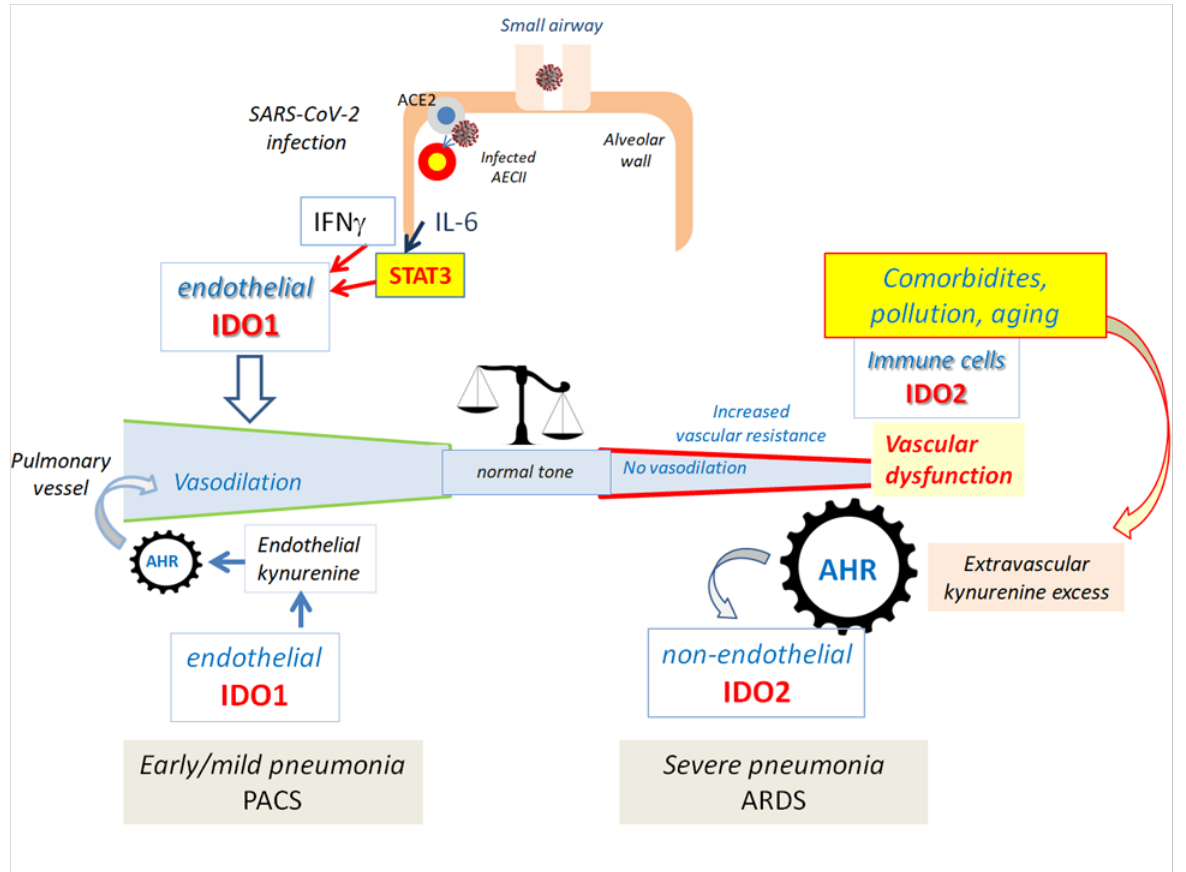
Figure 2. Hypothetical mechanisms involved in COVID-19 pneumonia, as discussed in this review. After SARS-CoV-2 infection leading to early/mild pneumonia, inflammatory stimuli trigger endothe- lial IDO1 expression, kynurenine accumulation, and vascular relaxation. This mechanism may persist in post-COVID-19. In severe cases, a loss of vascular IDO1 expression is observed, likely resulting in impairement of vascular-tone control and induction of vascular dysfunction. The occurrence of antecedent abnormal AHR activation (related to old age, comorbidities, and/or pollution) may concur in altering the kynurenine levels and the switch from IDO1 to